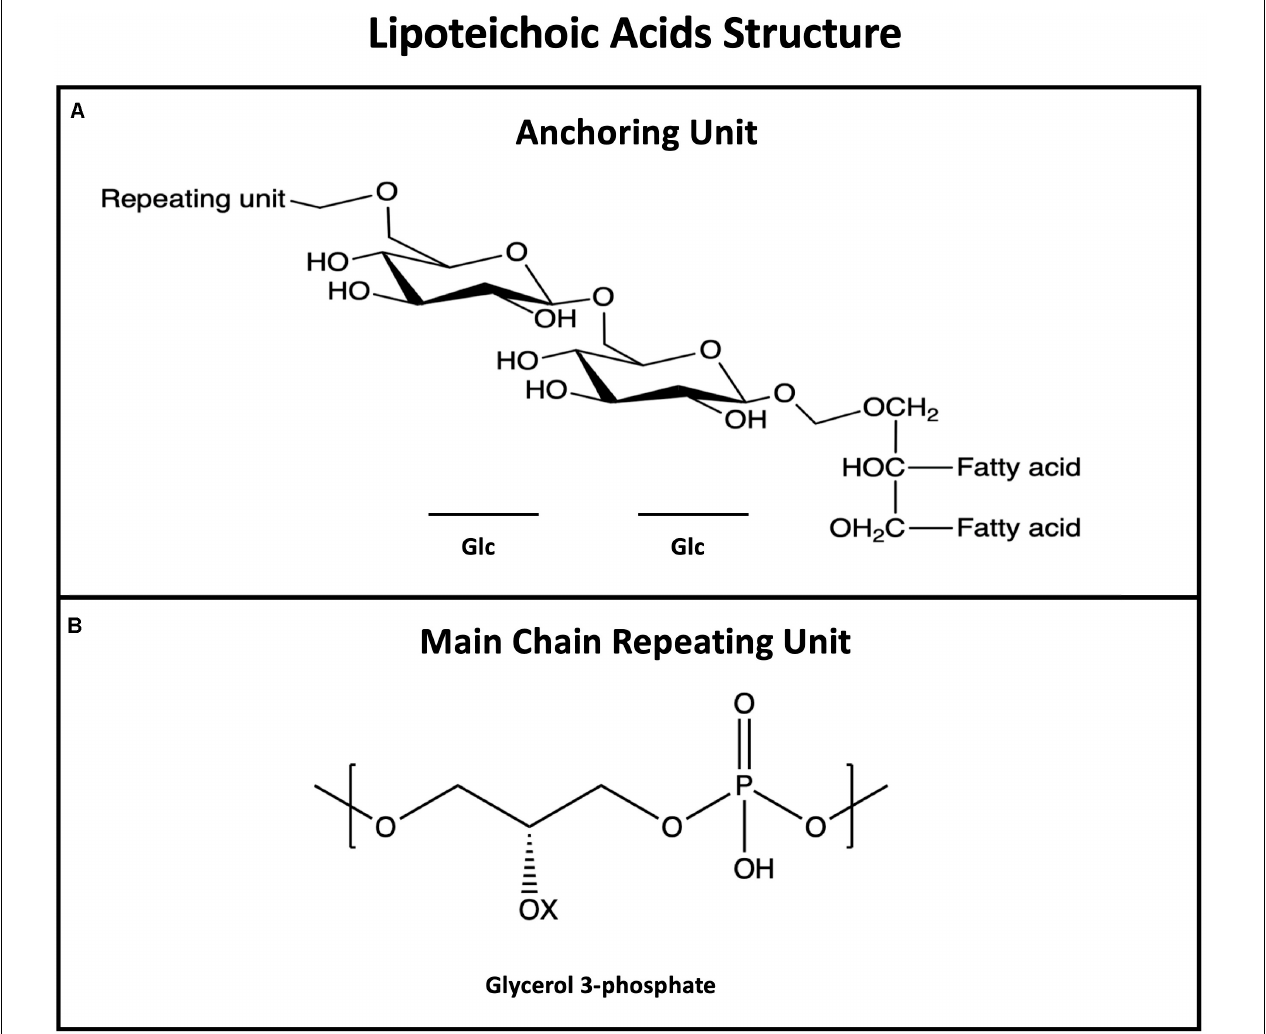
FIGURE 2 | General structure of lipoteichoic acids (LTAs) showing the membrane anchoring moiety (A) and the most common repeating unit (B) . LTAs repeating unit is more conserved than WTAs; Opposite to WTAs, LTAs are not bound to peptidoglycan but anchored to the membrane via the fatty acid.